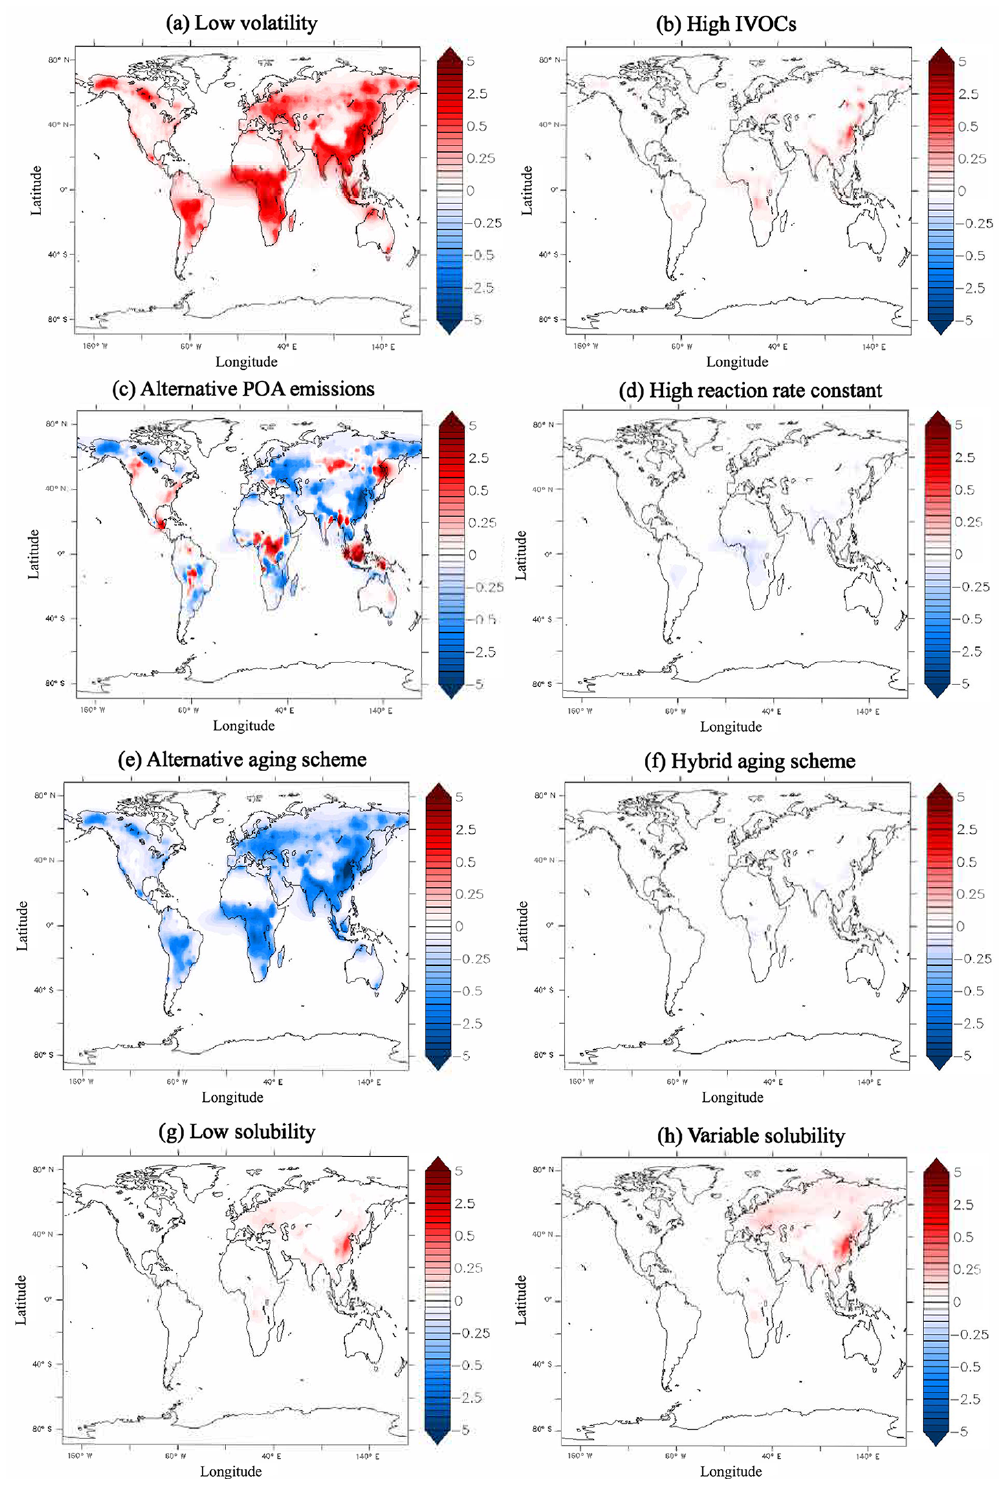
Figure 4. Absolute changes (inµgm − 3 ) of the average surface POA concentrations between the reference and the (a) low-volatility, (b) high IVOCs, (c) alternative POA emissions, (d) high reaction rate constant, (e) alternative aging scheme, (f) hybrid aging scheme, (g) low- solubility, and (h) variable solubility simulations during the period 2001–2010. A positive change indicates an increase in the sensitivity